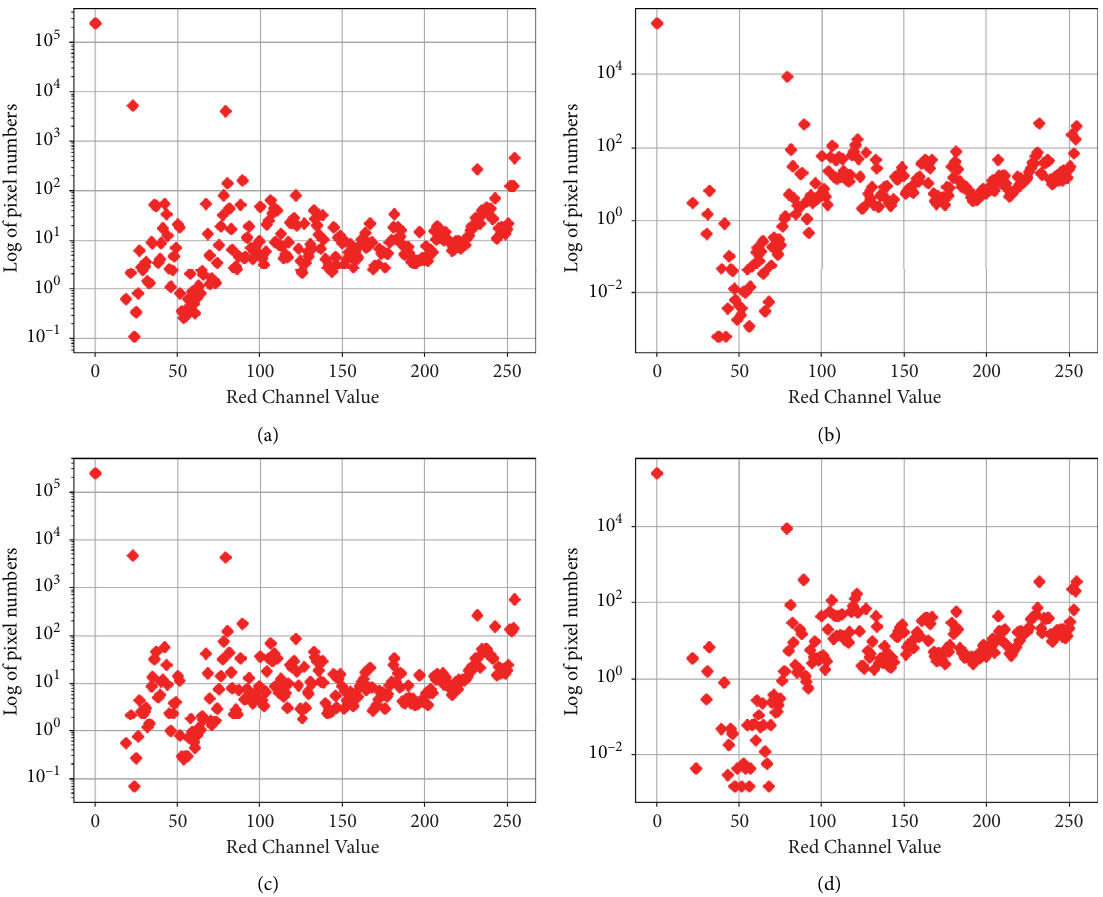
Figure 8: Feature in red channel captured by the traditional histogram method: the horizontal axis RedChannel Value is the color value of red channel, Red ChannelValue ∈ [ 0 , 255 ] ; the vertical axis is the logarithm calculation of the average number of pixels: (a) logarithm calculation of average number of pixels in red channel in morning peak hours out of restriction period, (b) logarithm calculation of average number of pixels in red channel in morning peak hours in restriction period, (c) logarithm calculation of average number of pixels in red channel in evening peak hours out of restriction period, and (d) logarithm calculation of average number of pixels in red channel in evening peak hours in restriction period. Monday evening box plot